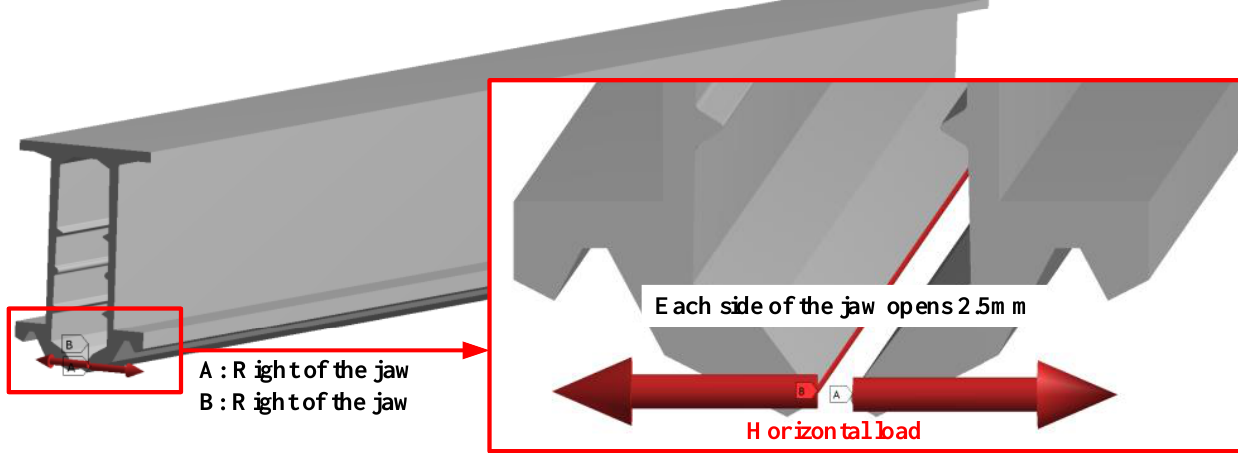
Figure 8. Schematics of applying clamping loads.